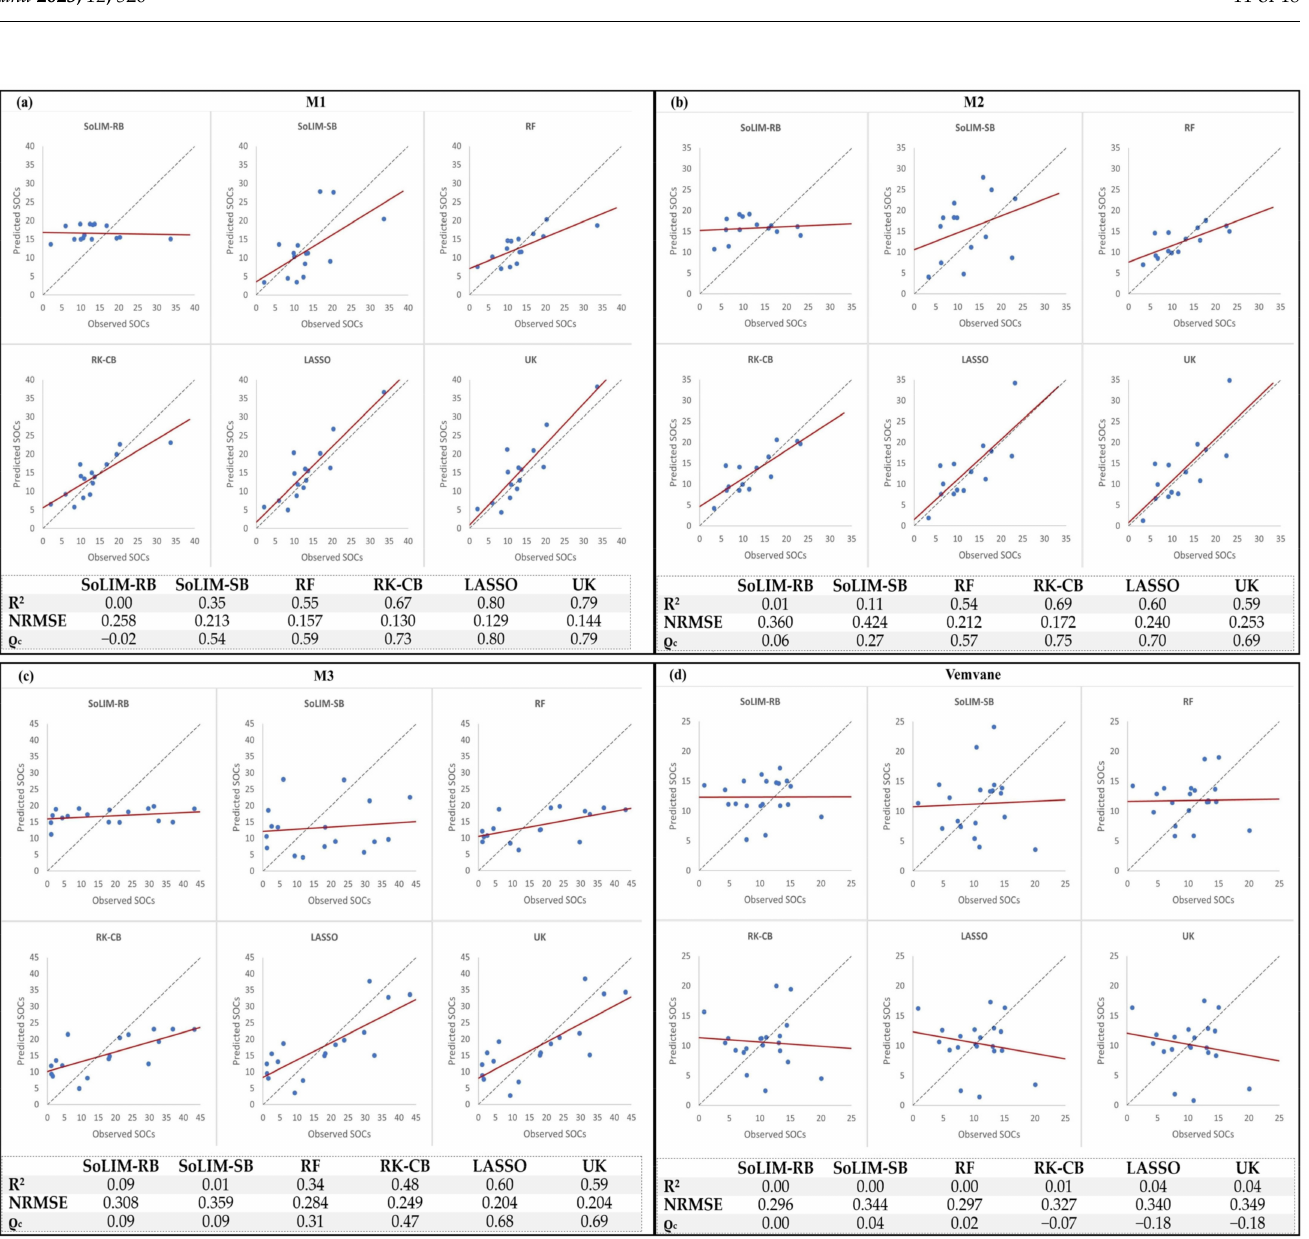
Figure 4. Linear regressions of inferred and observed SOCs for all models in M1 ( a ), M2 ( b ), M3 ( c ), and Vemvane ( d ). The statistical indicators used were R 2 , normalized root mean squared error (NRMSE), and the concordance coefficient ( ρ c). The dotted line reflects the 45 ◦ line that provides a 1:1 ratio for predicted and observed values, whereas the red line illustrates the regression